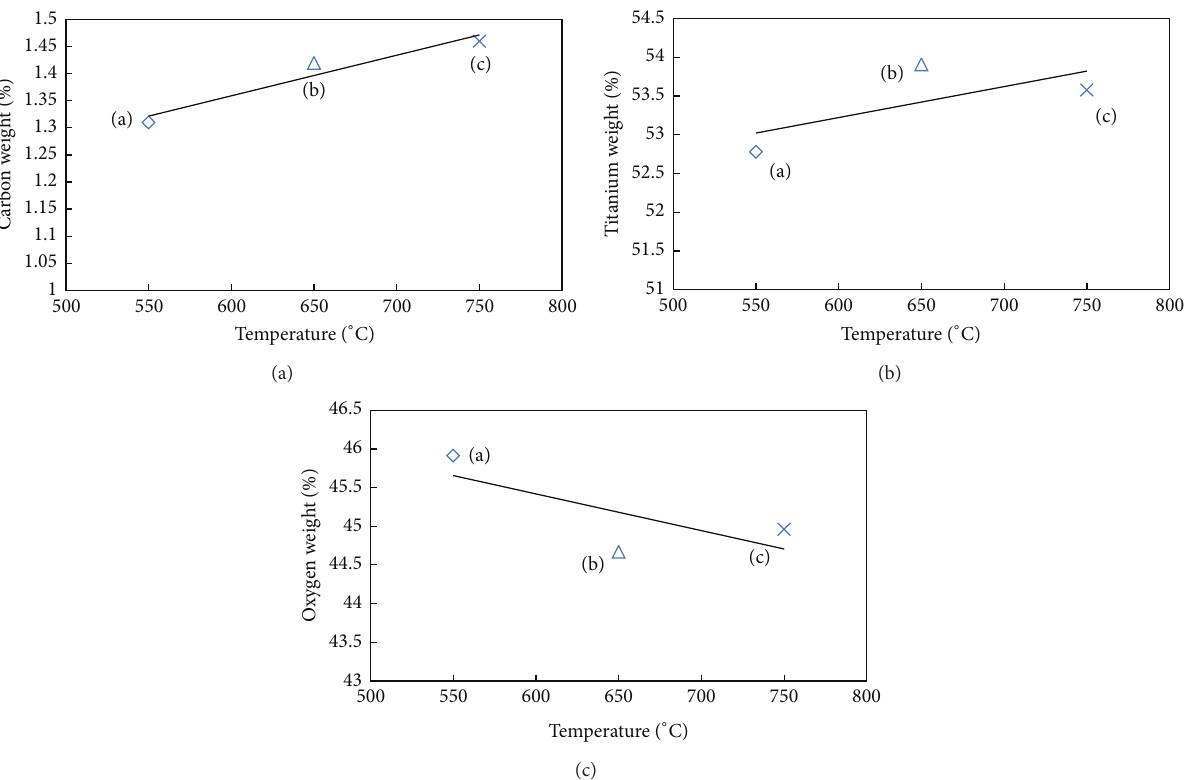
Figure 6: EDX graphical data for (a) carbon, (b) titanium, and (c) oxygen versus annealing temperature.